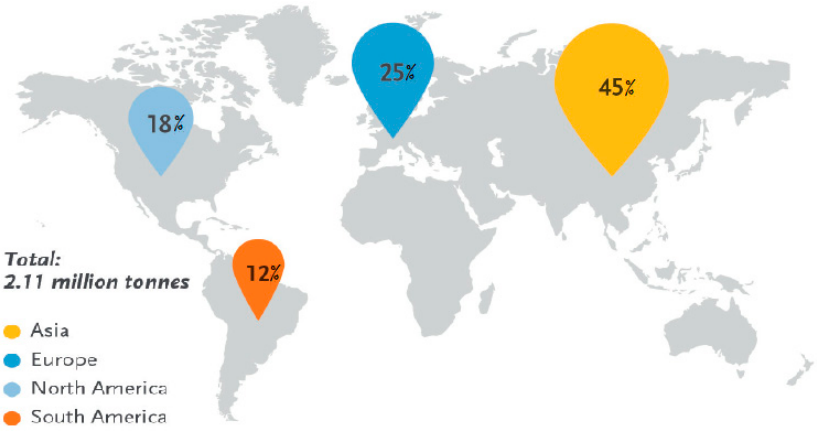
Figure 4. Global production capacities of bioplastics in 2019. Adapted from [65].